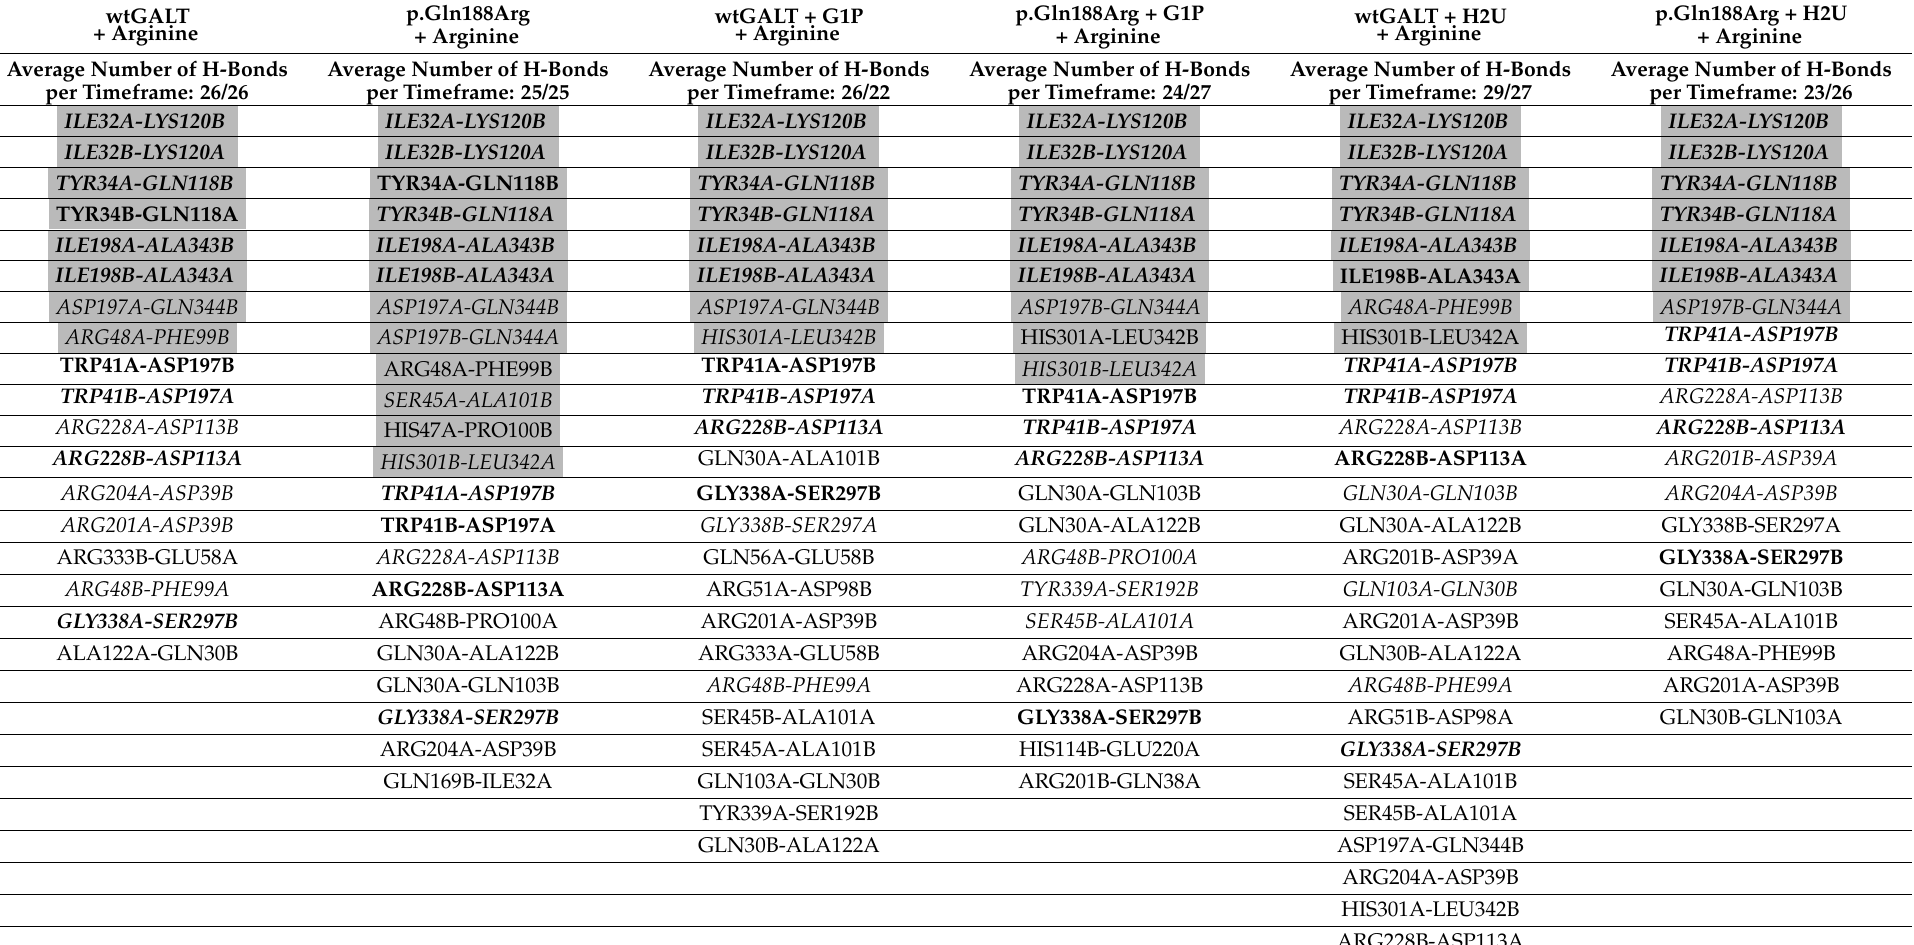
Table 2. Couples of residues involved in stable intersubunit H-bonds in simulations with arginine in the active site. The average number of H-bonds per timeframe is reported for each replica. Dark gray background: intersubunit interactions identified in the initial models and conserved throughout the simulations; bold: stable interactions present in all systems; italics: interactions maintained in the two replicas of each system. Couples of residues are considered to have a stable H-bond interaction when the sum of % of existence of the H-bonds between the two residues is ≥